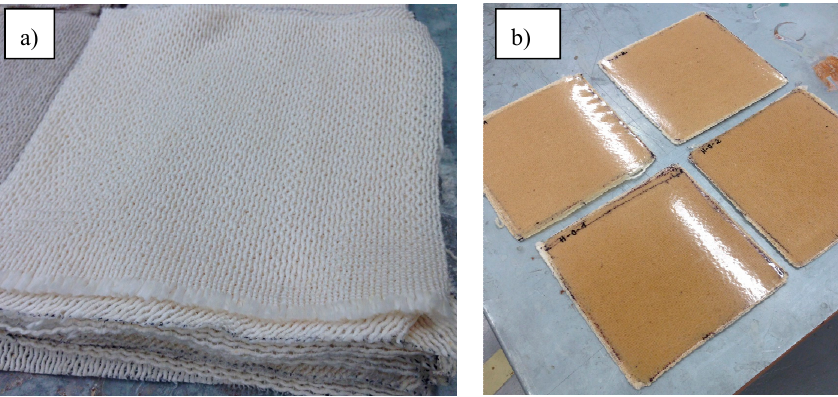
Figure 1. ( a ) The hybrid yarn warp-knitted prepreg fabric and ( b ) the manufactured composites. Table 2. Processing methods for the composite fabrication.